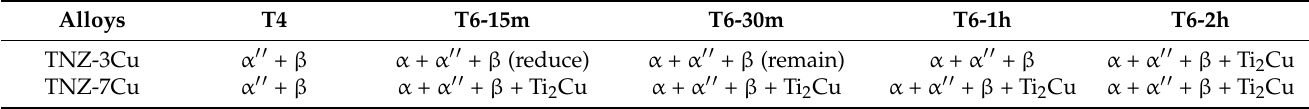
Table 1. Phase constitution of TNZ-xCu at different